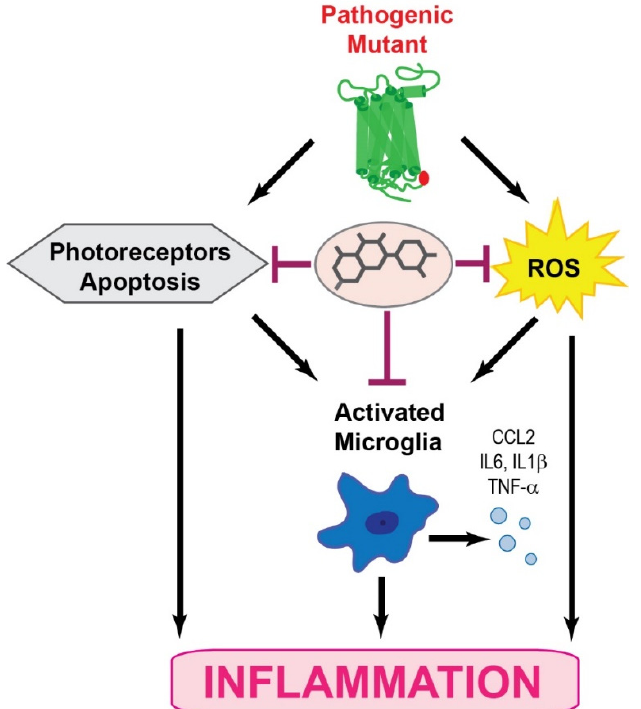
Figure 3. Prevention of RP retinal damage by flavonoids. The amino acid substitution of Pro23 to His in rhodopsin results in a structurally unstable receptor prone to aggregation in the endoplasmic reticulum ER, which induces the unfolded protein response (UPR) signaling and triggers the gen- eration of reactive oxygen species (ROS). In addition, continuous stress caused by the pathogenic mutation leads to the activation of other cellular factors such as the microglia. Dysregulated microglia activation under sustained stressors enhances the inflammatory response, triggering the activation of the apoptotic process in the photoreceptor cells and RPE. Treatment with quercetin stabilizes the pathogenic rhodopsin mutant, which inhibits ROS generation, attenuates microglia activation, and slows down photoreceptor